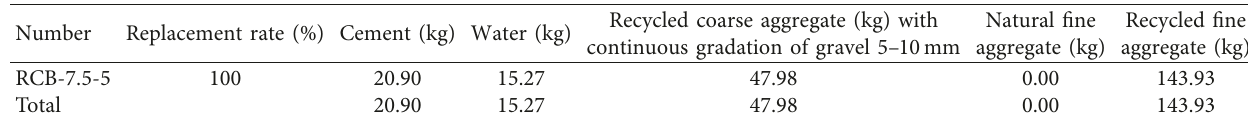
Table 4: Quantity of materials required for the MU7.5 block experiment.